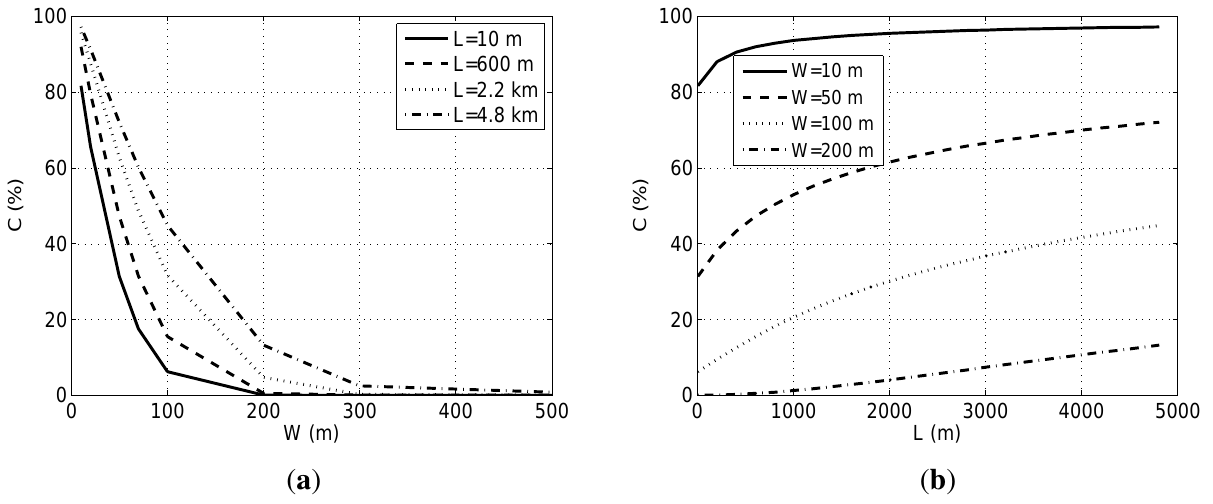
Figure 2. Choking factor (C) as a function of ( a ) width of the channel (W); and ( b ) length of the channel (L). The choking factor is defined as the range of the water level in the basin divided by the range of the water level in the open